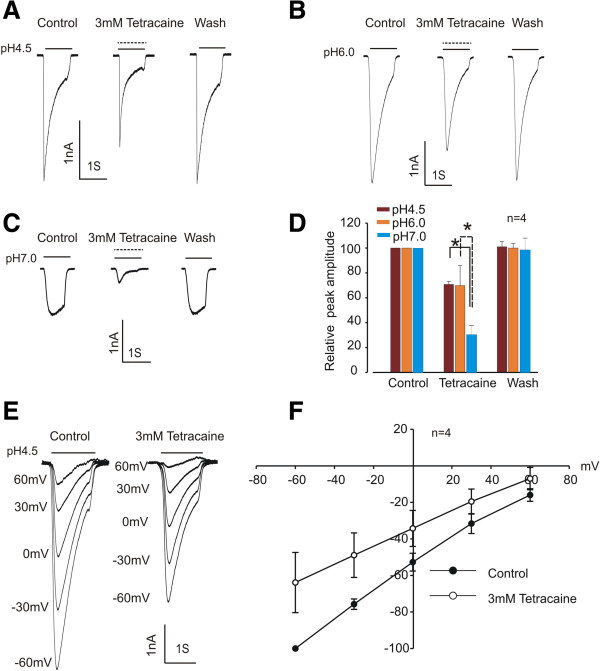
pH-dependent and voltage-independent inhibition of ASIC3 currents by tetracaine. A, B, C. Representative current traces showing inhibition of ASIC3 currents by 3 mM tetracaine at pH4.5, pH6.0, and pH7.0, respectively. D. Summary data showing inhibition of the ASIC3 current by 3 mM tetracaine at different pH levels as indicated (t test, n = 4; *p < 0.05). E. Representative current traces showing ASIC3 current activated at different holding potentials ranging from −60 to +60 mV in the absence and presence of 3 mM tetracaine. F. Current–voltage relationship (I-V curve) in the absence and presence of 3 mM tetracaine; n = 4.